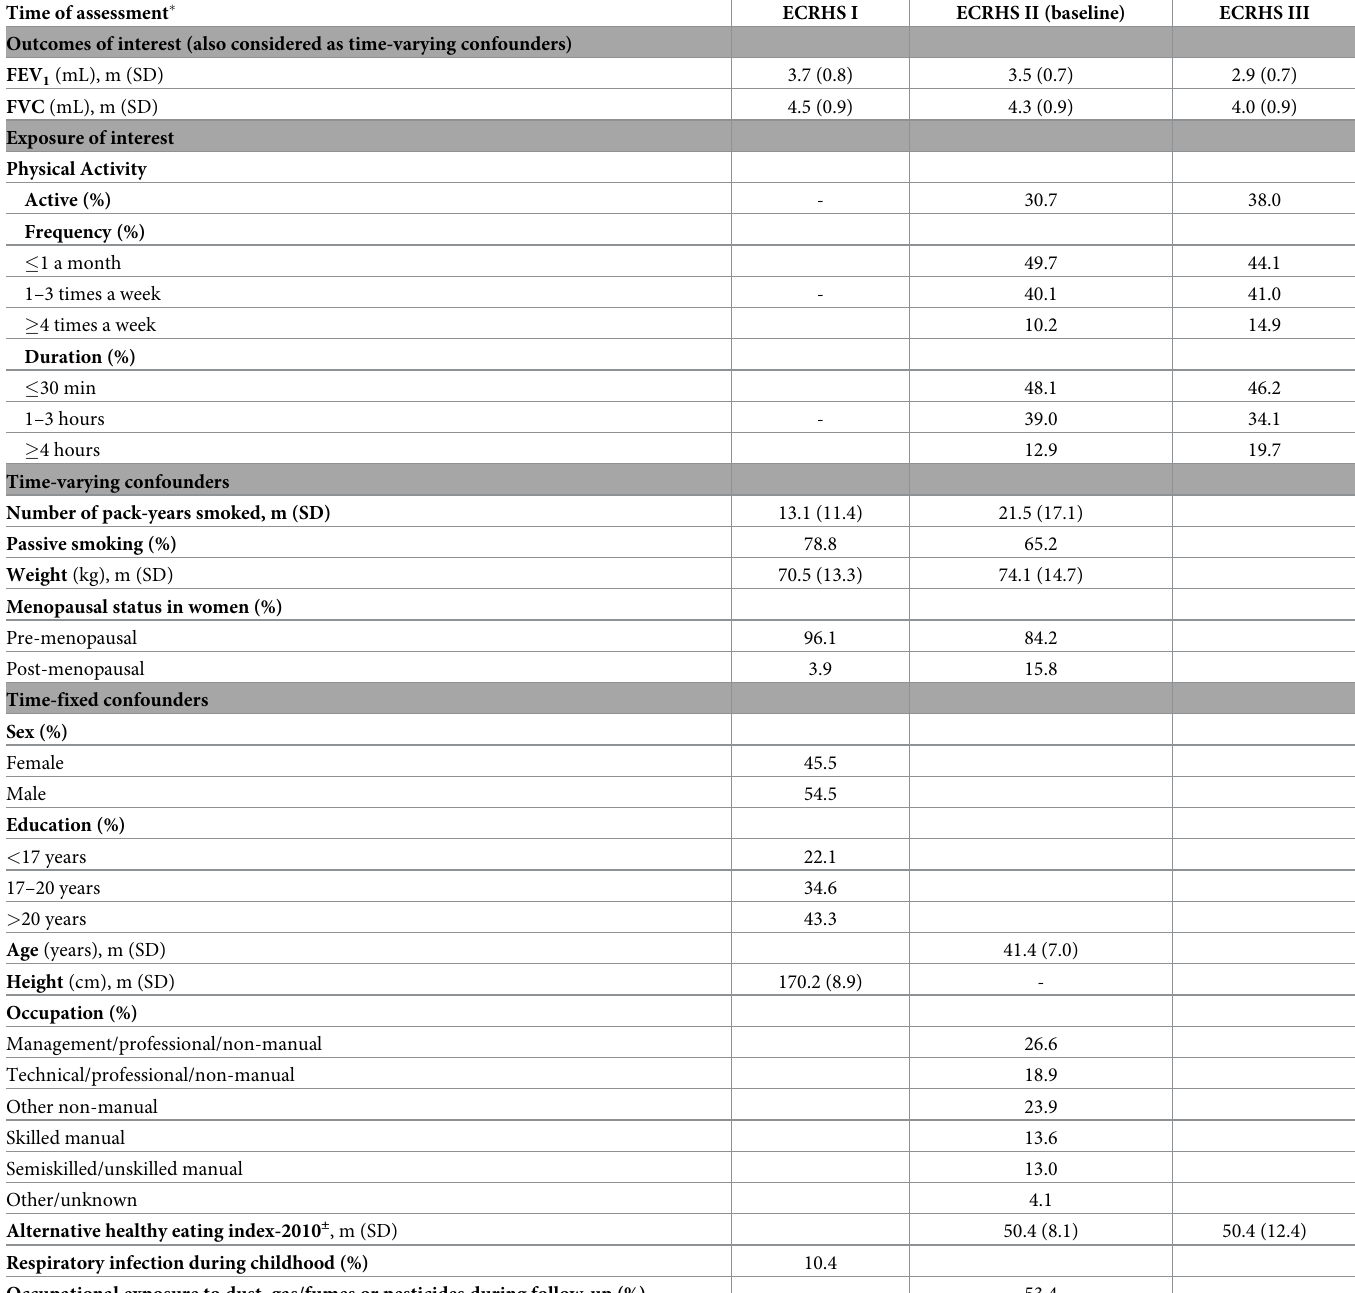
Table 1. Description of the study population (n =